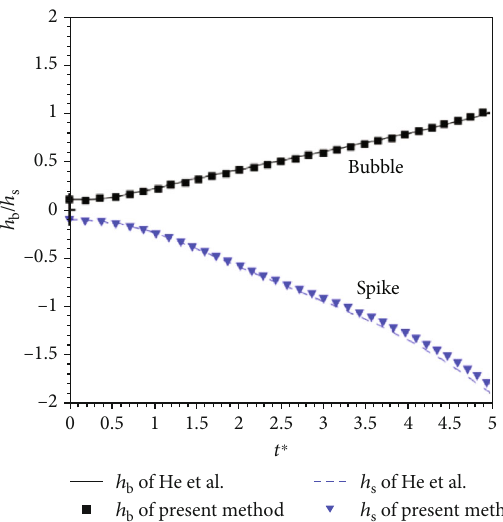
Figure 10: Comparison of the bubble and spike front-positions between present results and those of He et al. [21].